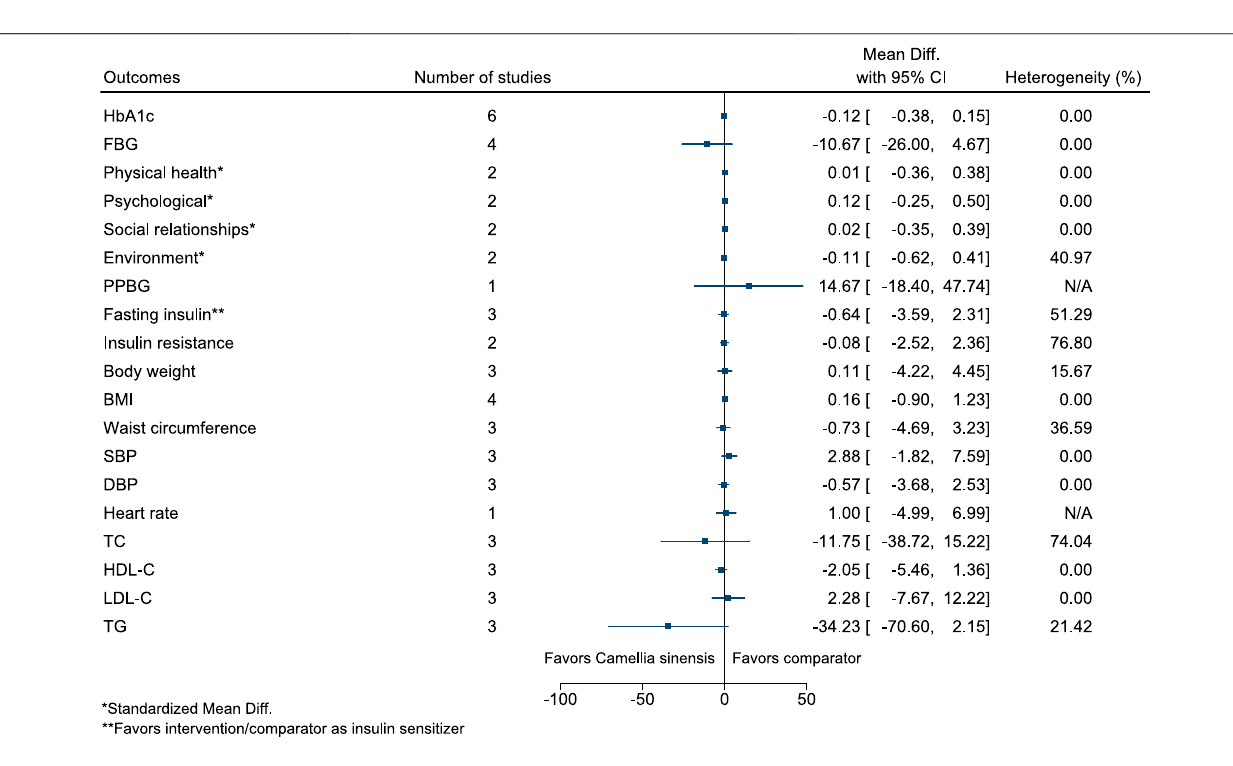
FIGURE 8 | Camellia sinensis — Summary forest